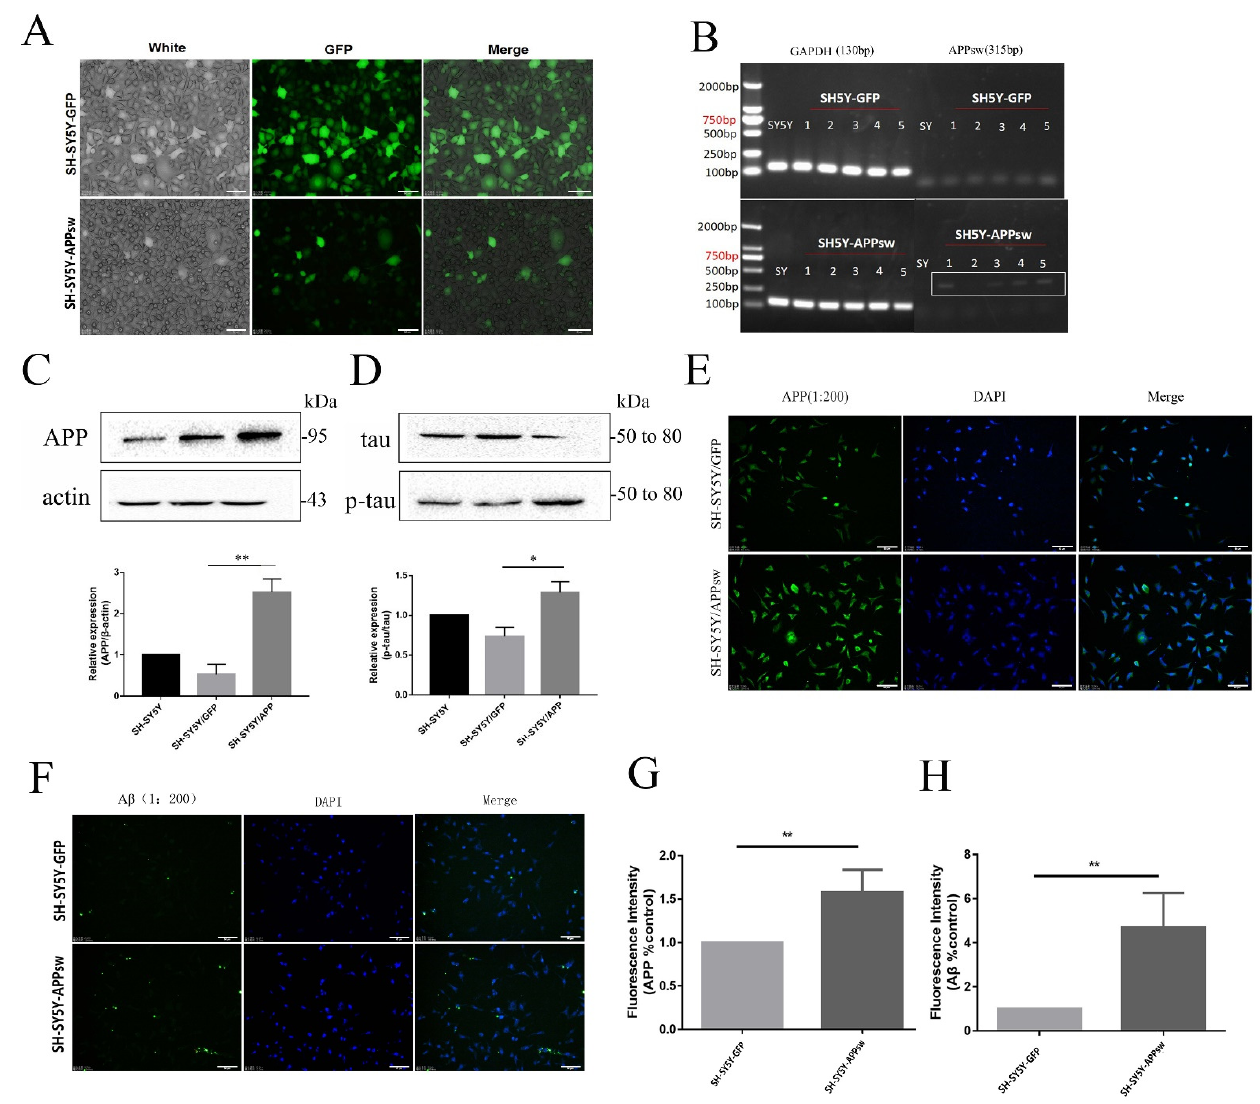
Figure 1. SH-SY5Y cells transfected with the APPsw gene were established as an AD cell model. ( A ) The transfection efficiency was observed in SH-SY5Y cells. ( B ) The expression of the APPsw gene was detected in different SH-SY5Y cell clones using RT-PCR. ( C ) Immunoblot analysis of APP levels in GFP- and APPsw-positive cells. Quantification of APP levels normalized to β -actin levels, and the results are presented as a % of the control and showed significant differences between SH-SY5Y cells and APPsw-positive cells ( p < 0.01). ( D ) Immunoblot analysis of tau and p-tau levels in GFP- and APPsw-positive cells. Quantification of p-tau levels normalized to tau levels, and the results are presented as a % of control and showed significant differences between SH-SY5Y cells and APPsw- positive cells ( p < 0.05). ( E , G ) Immunofluorescence staining for APP in GFP- and APPsw-positive cells ( p < 0.05). ( F , H ) Immunofluorescence staining for A β in GFP- and APP-positive cells ( p < 0.05). Scale bar = 50 μ m ( A , E , F ). Significant differences were determined using Student’s t -test. All values are presented as the means ± SD from three experiments. * p < 0.05, ** p < 0.01.